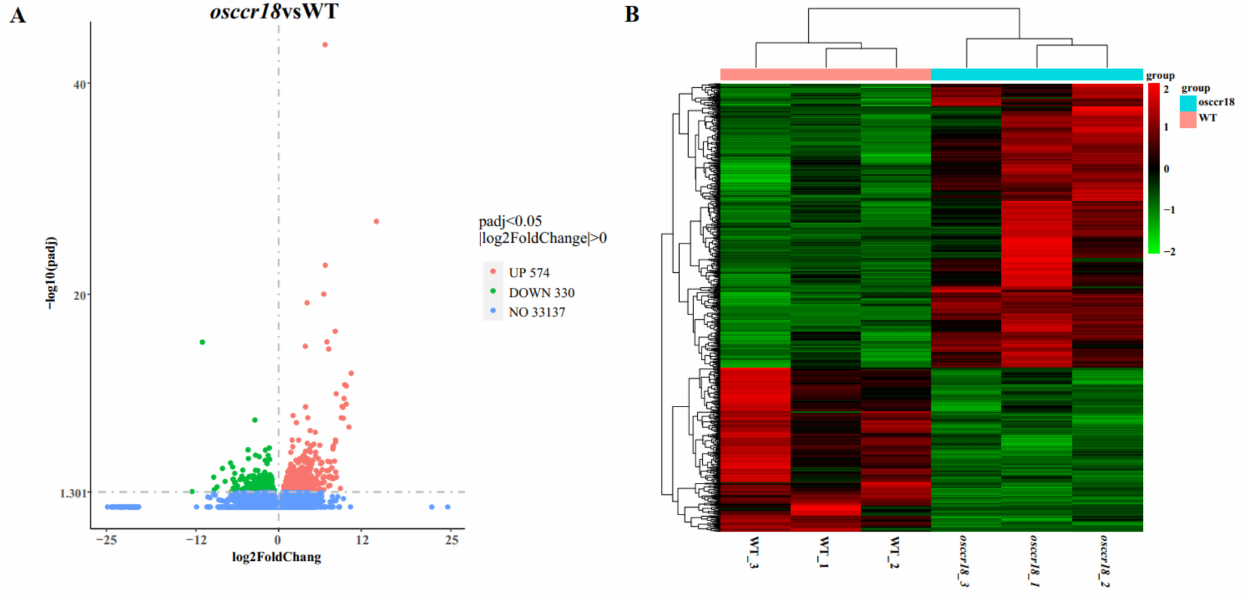
Figure 6. Analysis of differentially expressed genes (DEGs) at the S9 stage during anther devel- opment in osccr18 mutants and WT . ( A ) The volcano plot of DEGs. The red and green dots represent the up– and downregulated DEGs in osccr18 mutants compared with WT. ( B ) Clustering heat map of DEGs. The analysis was performed using the normalized expression level of DEGs with three biological replicates of osccr18 and WT samples.